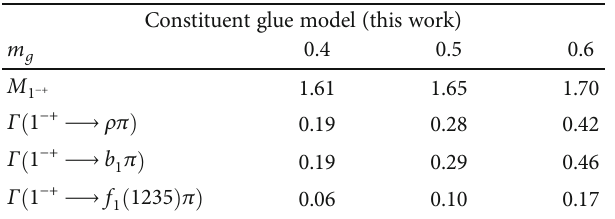
Table 3: The 1 − + hybrid masses and the decay widths (in GeV) from the QMGC